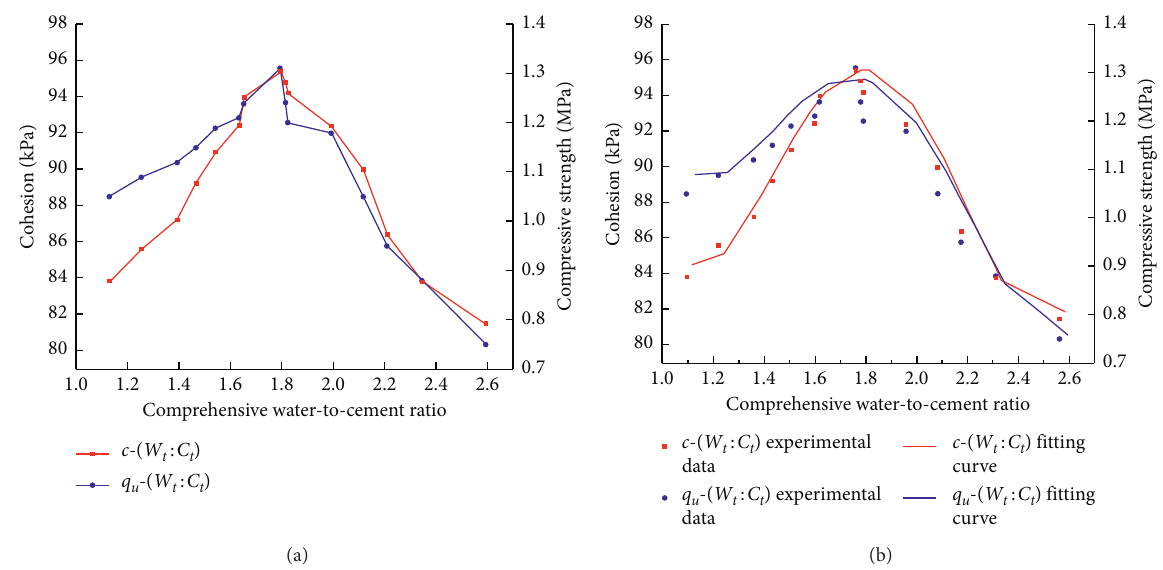
Figure 9: Measured data and fitting curves of reinforced samples’ cohesion and compressive strength with respect to the comprehensive water-to-cement